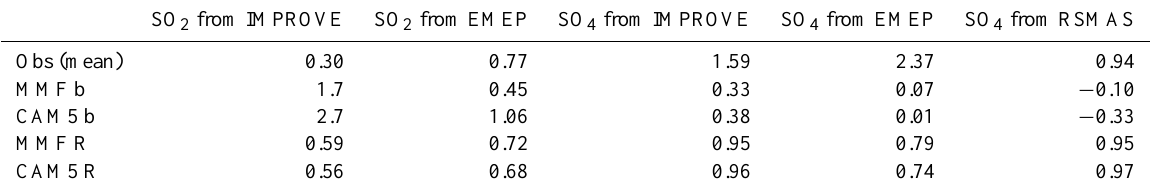
Table 3. Observed means, normalized mean biases ( b ) and correlation coefficients ( R ) between models and observations for SO 2 , and SO 4 . Annual average data is used. Observations are from the United States Interagency Monitoring of Protected Visual Environment (IMPROVE) sites (http://vista.cira.colostate.edu/improve/), the European Monitoring and Evaluation Programme (EMEP) sites (http://www.emep.int), and the ocean network sites operated by the Rosenstiel School of Marine and Atmospheric Science (RSMAS) at the University of Miami (Prospero et al., 1989; Savoie et al., 1989, 1993; Arimoto et al., 1996). See Figs. 9–10 in Wang et al. (2011) for the scatter plots of MMF results versus